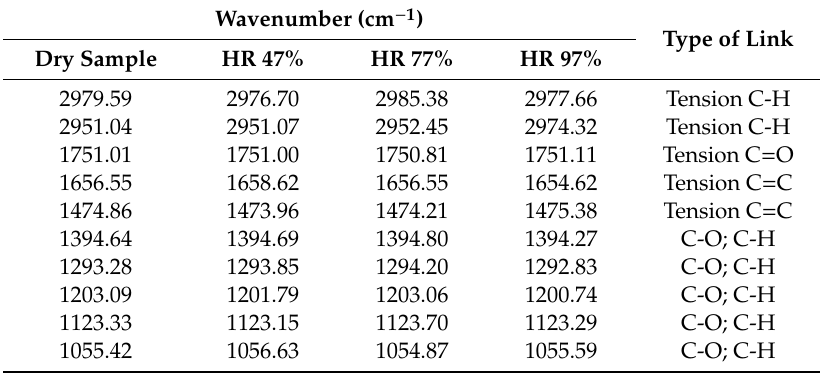
Table 2. Characteristic bands and type of bond for the Mopa-Mopa